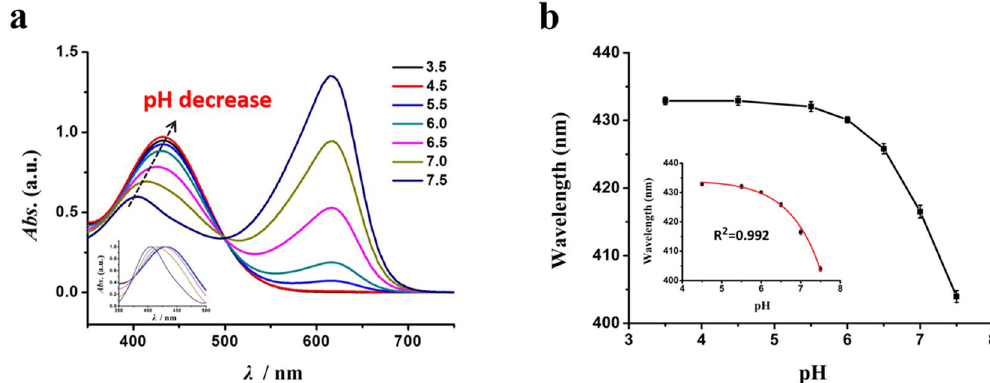
Figure 3. UV-Vis absorption spectra and calibration curve of bromothymol blue/PBS solutions with different pH values. ( a ) Traditional UV-Vis absorption spectra of bromothymol blue/PBS solutions (10 mM) with varied pH values. The inset is the normalized UV-Vis absorption spectra of 350–500 nm for bromothymol blue/ PBS solutions (10 mM) with varied pH values. ( b ) The calibration curve of bromothymol blue solutions in terms of the pH-dependent UV-Vis absorption peak for pH measurements. Inset shows the calibration curve from pH 4.5 to 7.5. The error bars illustrate the relative standard deviation (RSD) over three replicates.